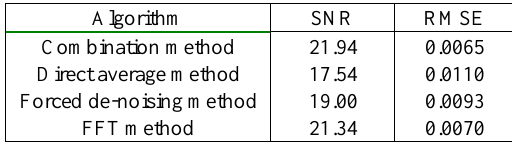
Table 1. SNR and RMSE of different de-noising algorithms In the Table 1, the SNR of combination method is highest